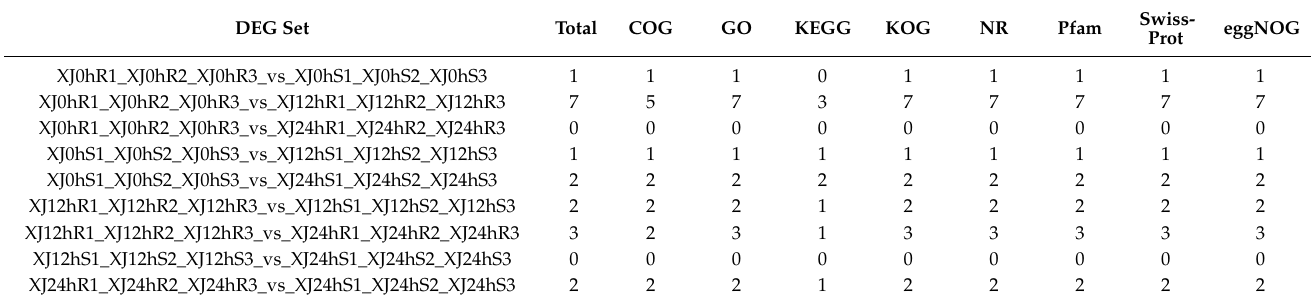
Table 7. Annotated statistical table of the number of differentially expressed circRNA source genes.